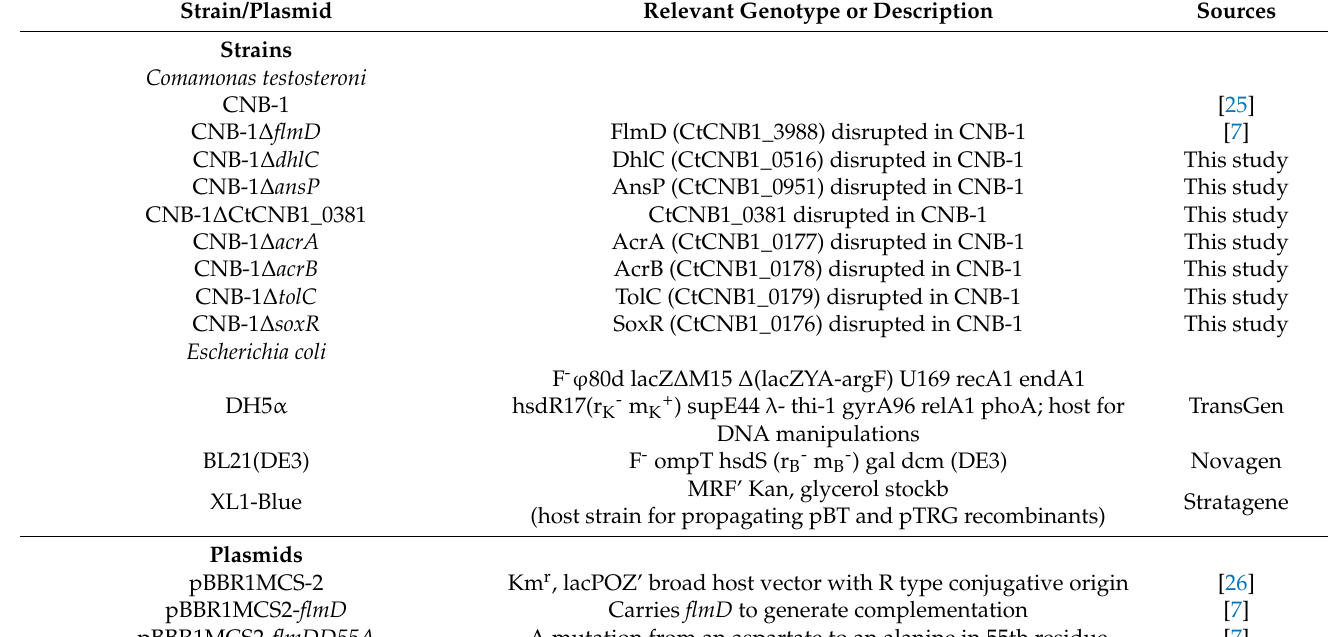
Table 1. Strains and plasmids used in this